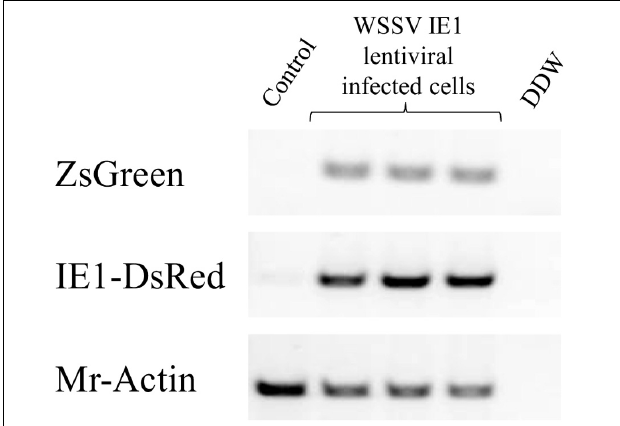
FIGURE 3 | PCR analysis (using specific primers) of lentiviral sequences (ZsGreen and IE1-DsRed) in three different genomic DNA extractions from M. rosenbergii primary cells following transduction with WSSV IE1 lentiviruses. Mr-actin served as the positive control for M. rosenbergii cell cultures. Control, uninfected M. rosenbergii cells; DDW, double distilled water.